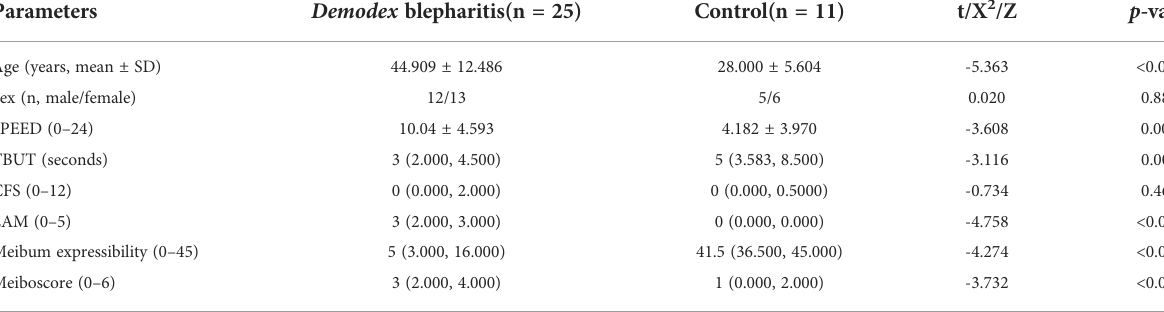
TABLE 1 Clinical parameters of the two groups in the study